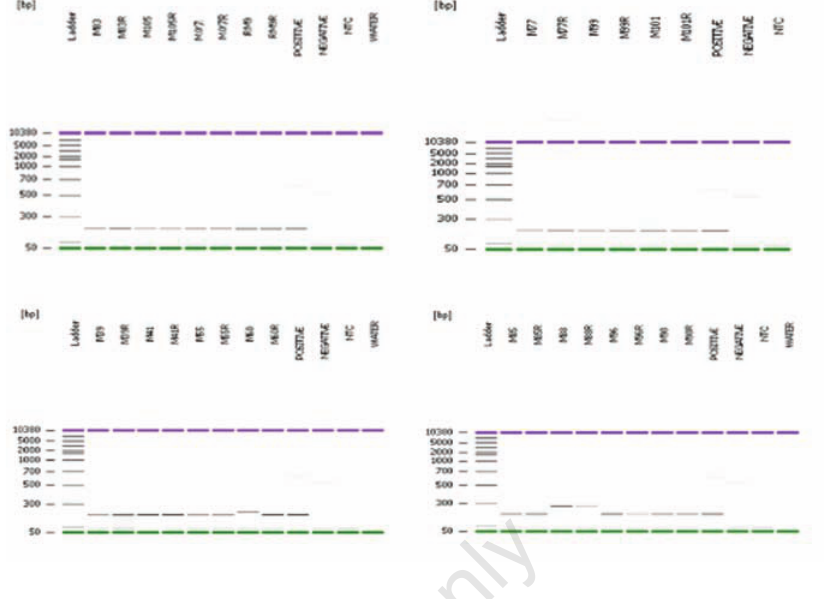
Figure 1. Polymerase chain reaction (PCR) products of 15 BCL1/JH t(11;14)(13q;32q) positive multiple myeloma patients on bioanalyzer. Each sample was performed in dupli- cate. PCR product size ranged between 200bp-300bp. Negative controls and samples showed a faint unspecific band at ~600bp. No band was observed in the non-template controls and water controls indicated that there was no cross-contamination of reagent during the PCR preparation.